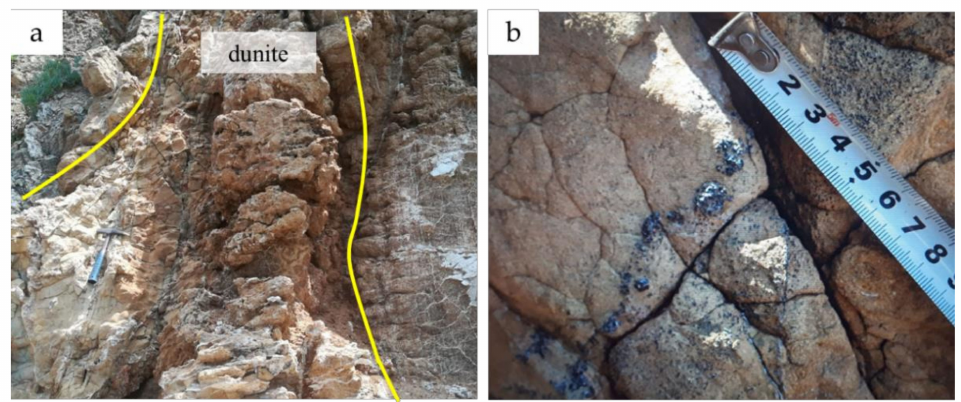
Figure 5. Pictures of ( a ) dunite dyke hosted within harzburgite at Nea Roda; ( b ) small chromitite bands within dunite